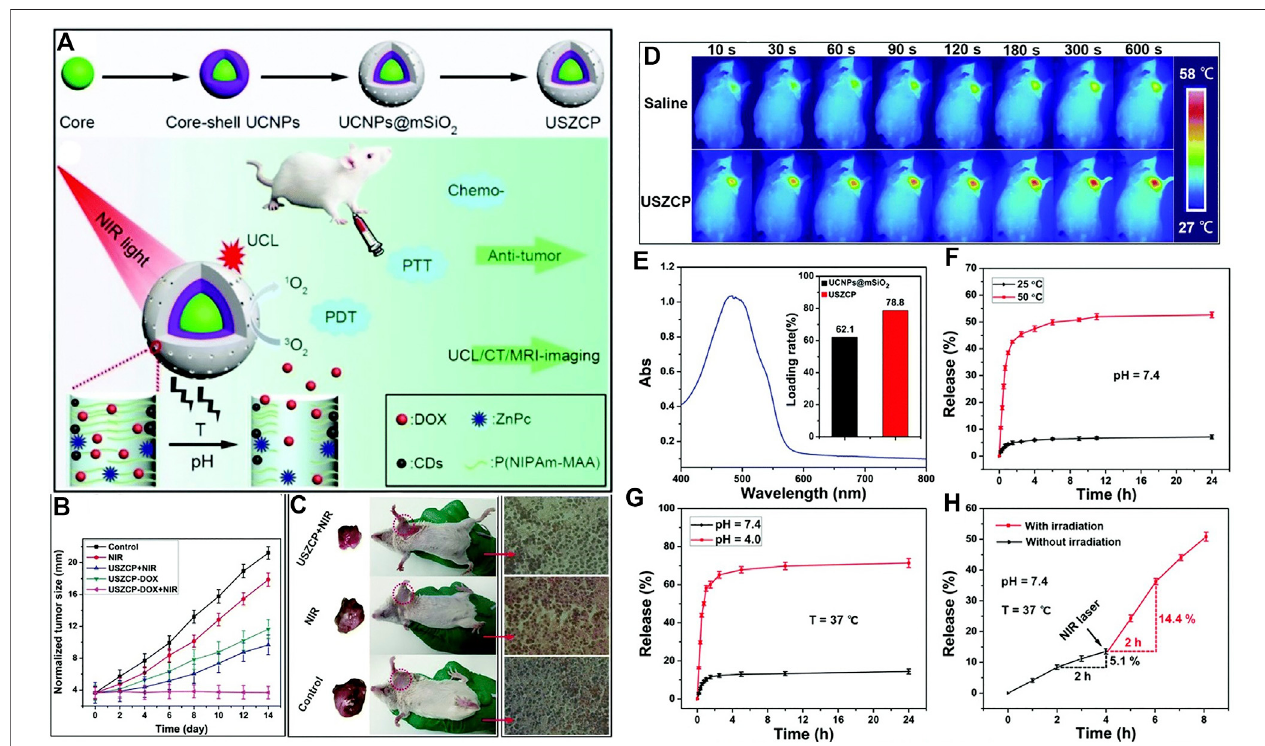
FIGURE9|(A) SchematicillustrationofpH-temperaturesensitivepolymerforcancertherapy. (B) ChangesinthetumorsizeoftheH22tumorobtainedfrommiceafter different treatments; (C) Picture oftumor and H&E staining; (D) in vivo infrared thermal images ofa tumor-bearing mouse after injection of USZCP under NIR irradiation with different times; (E) UV-vis absorption spectrum of DOX (inset shows the DOX loading content of UCNPs@mSiO2 and USZCP); the release ef fi ciency of USZCP – DOX at different (F) temperatures and (G) pH values; (H) the release ef fi ciency of USZCP – DOX triggered by a NIR laser. Reprinted with permission from Xu et al.